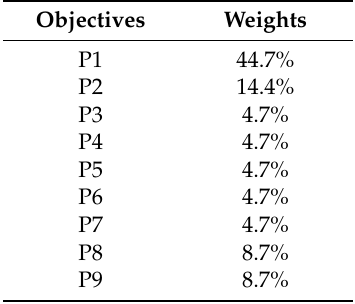
Table 3. Pairwise comparisons with the final weight of each objective by AHP.